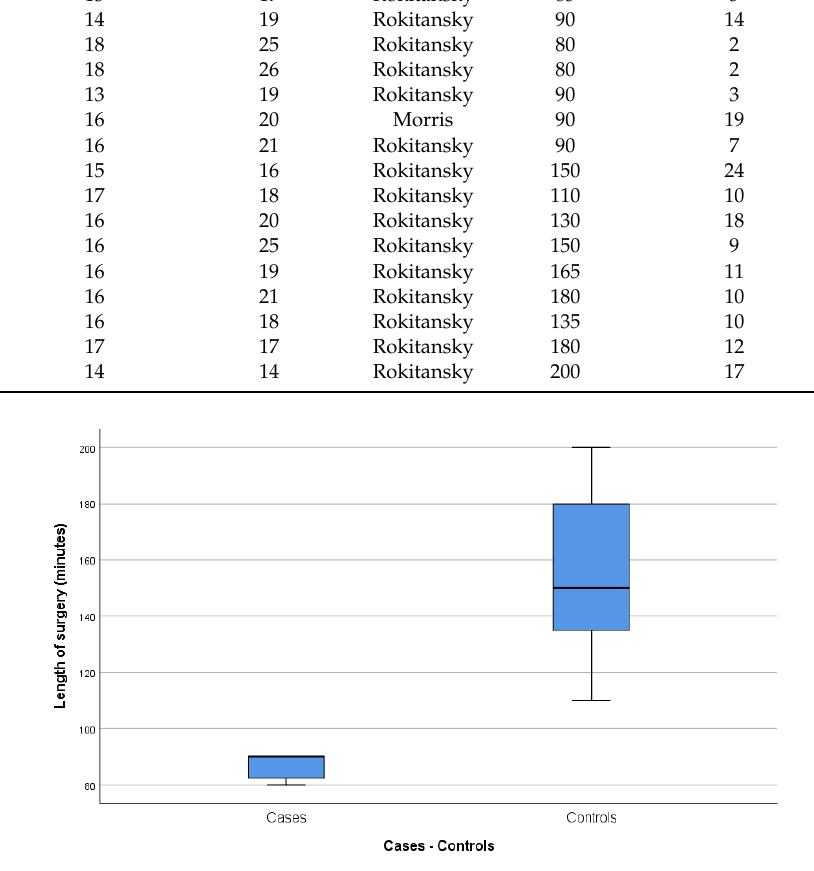
Figure 1. Length of surgery (minutes).